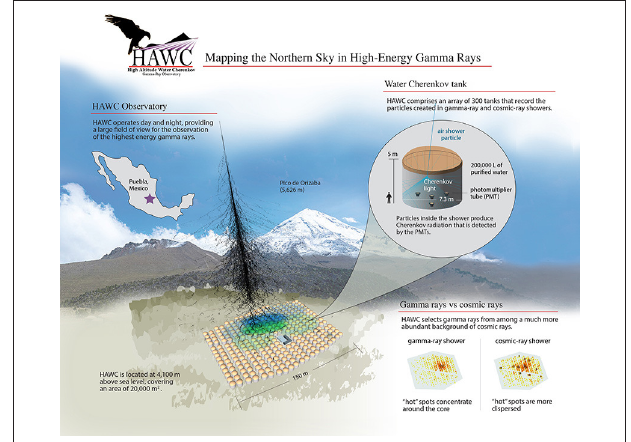
FIGURE 1 | The HAWC Observatory is a next-generation gamma-ray detector placed at an altitude of 4,100 m on the slope of the dormant volcano Pico de Orizaba in Mexico 1